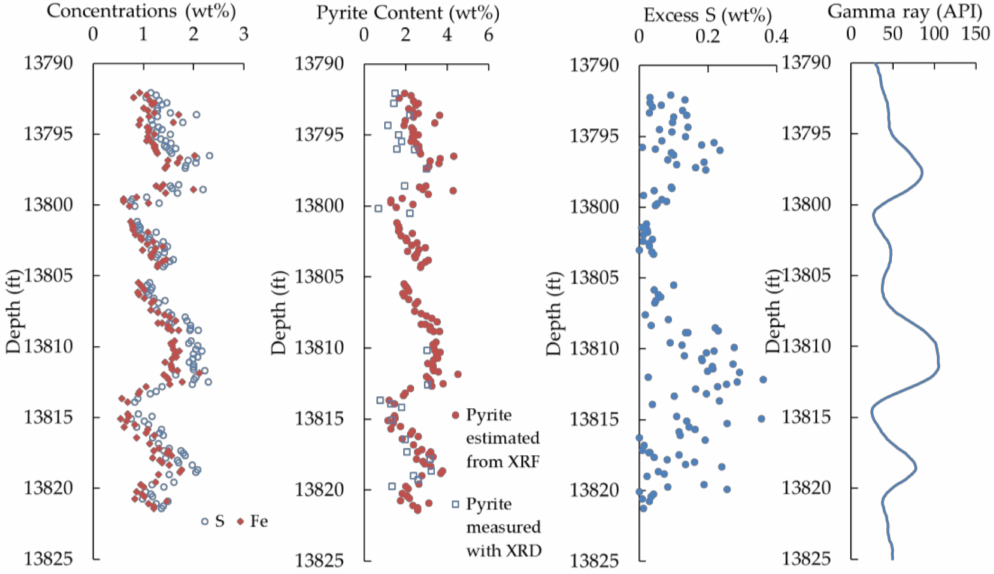
Figure 4. Changes of Fe and S concentrations, pyrite content, and residual S, corresponding to the gamma ray intensity changes in the Eagle Ford Shale (depth ranges from 13,790 ft to 13,825 ft). XRF—X-ray